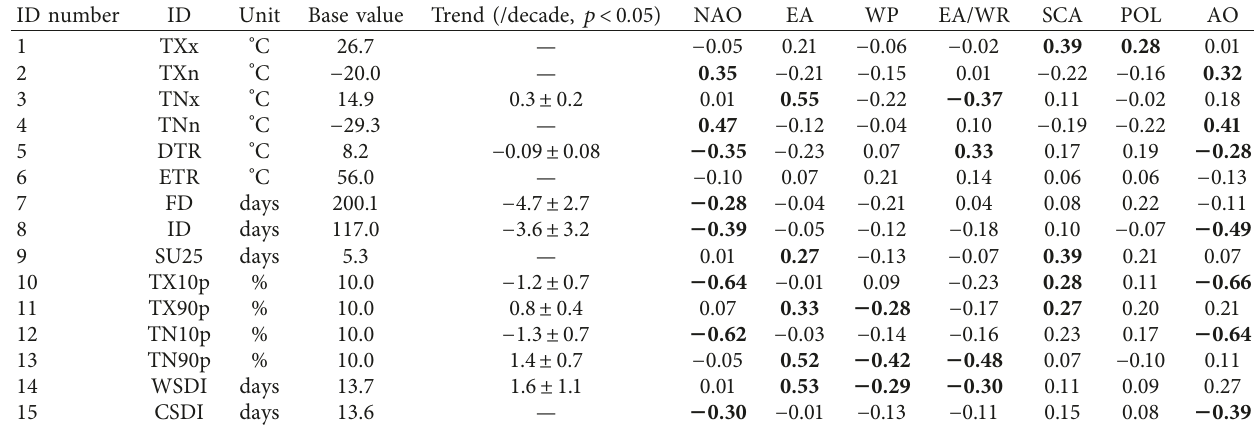
0 . 05) trends, and Spearman rank correlation ( ρ ) with NHTPs <